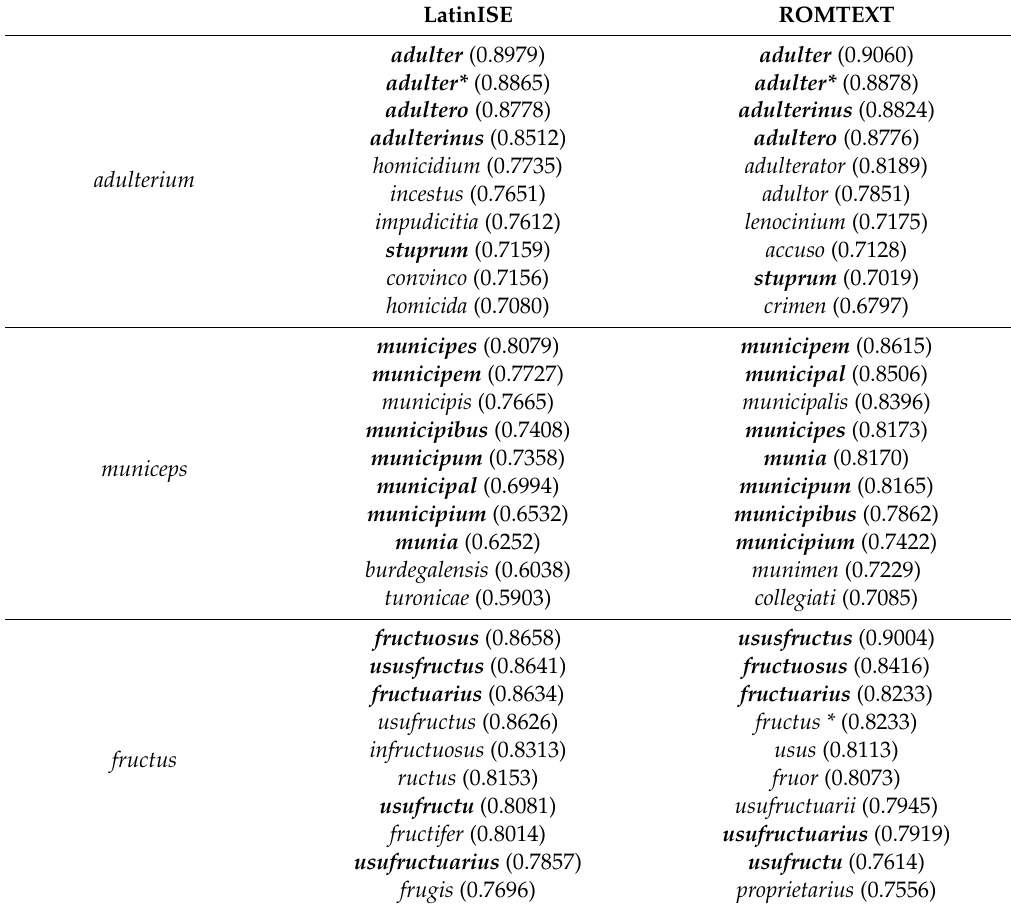
Table 4. Top 10 semantic neighbours and their fastText similarity score for three target words. Overlapping words in the top 10 semantic neighbours generated by the word embeddings models based on the LatinISE and ROMTEXT corpora are highlighted in bold. Words with an asterisk are those which are returned by the lemmatizer as homonyms with di ff erent